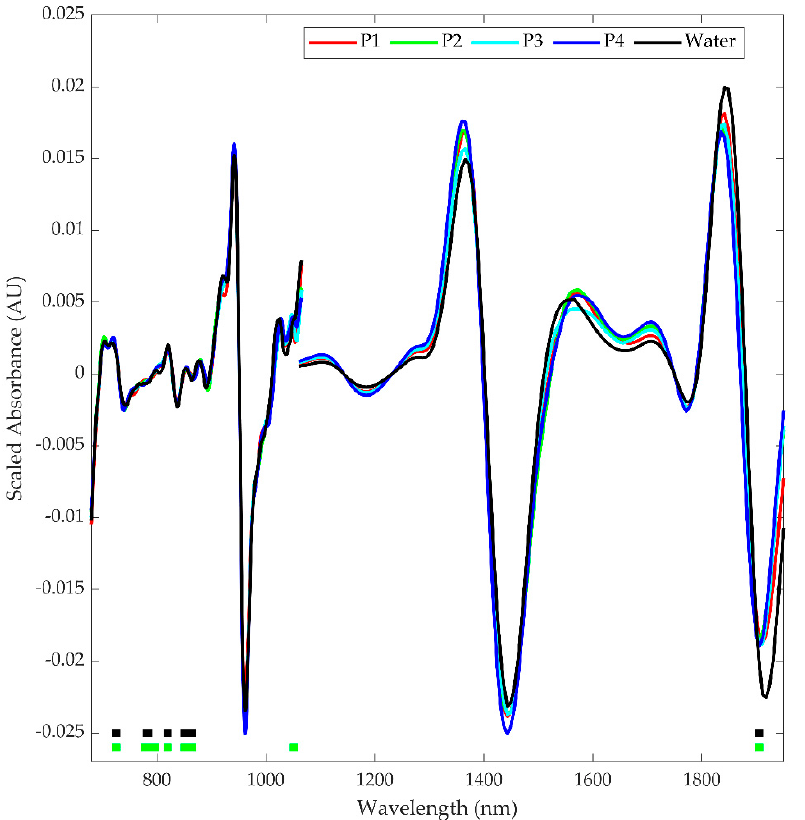
Figure 4. The 2nd derivative NIR spectra of aqueous L-proline. Each spectrum of each concentration shows the average of 3 independent solutions. The NIR spectrum of pure water is shown in comparison. The wavelength areas presenting a systematic order with the solutions of different concentrations and water (P1 → P2 → P3 → P4 → water) are marked with a black rectangle, whereas solutions appearing in the order P1 → P2 → P3 to P4 or P1 → P2 → P3 to water were marked with a light green rectangle.